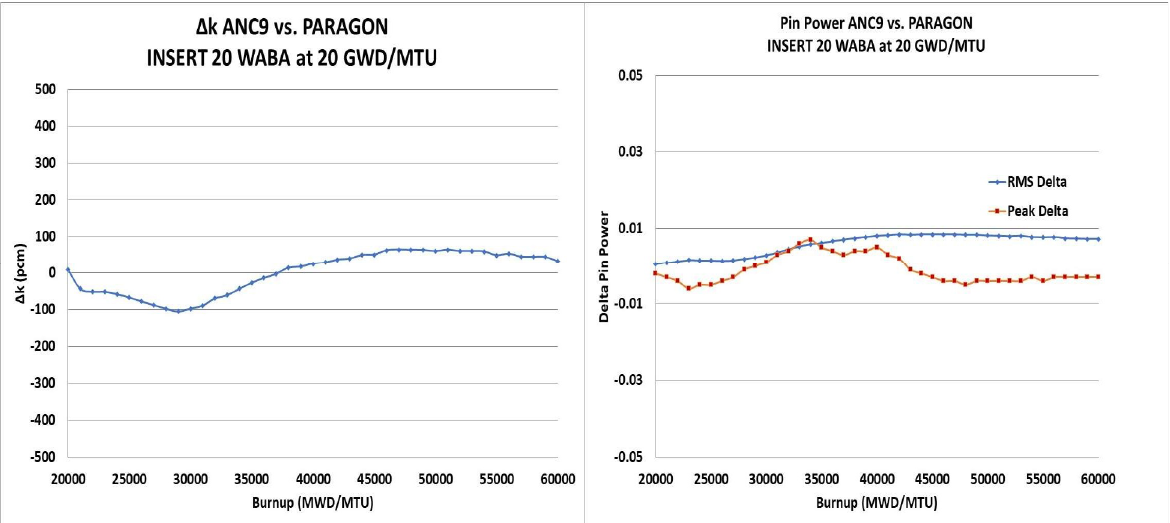
Figure 5. Comparison of eigenvalue and pin power for 20 WABA rods inserted at 20 GWD/MTU